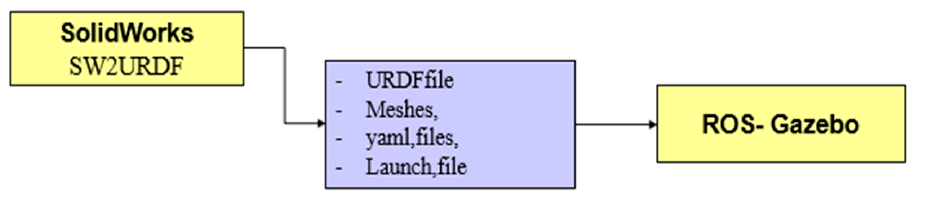
Figure 16. Modeling of an AGV system from Solid Works to Gazebo. Through CAD software, such as SolidWorks, the SysML BDD shown in Figure 13 helps the 3D CAD designer in modeling the AGV structure. This diagram defines the different components of the system with their physical properties. On the other hand, the Internal Block diagram (IBD) illustrated in Figure 17 explains the interactions between the components that help in defining the different links and joints between the AGV elements during the URDF file generation.